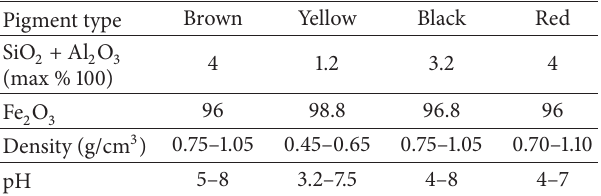
Table 3: Technical specifications of pigments.